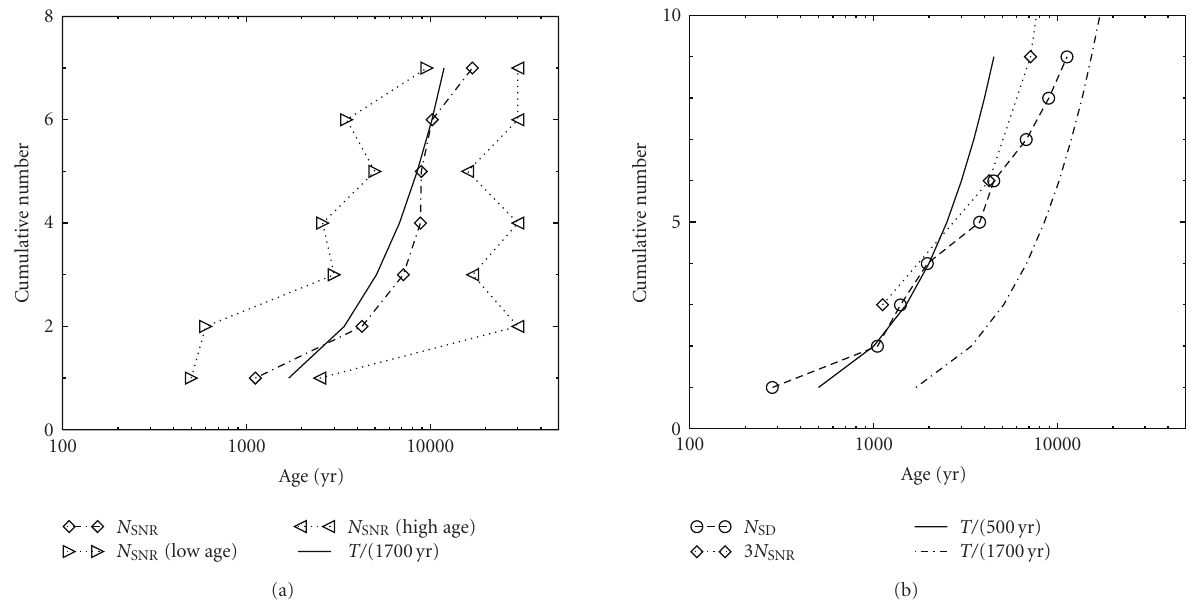
Figure 2: (a) shows the cumulative age distribution for SNRs associated with AXPs and SGRs (diamonds and dot-dashed line). The solid line is the expected distribution for constant birth rate of 1/(1700 years). The triangles indicate the upper and lower SNR age limits corresponding roughly to 3 σ limits. (b) shows the cumulative age distribution for AXPs/SGRs (circles and dashed line). The solid line is the expected distribution for constant birth rate of 1/(500 years). The diamonds and dotted line are the cumulative distribution for associated SNRs (from (a)) scaled up by a factor of 3. To better illustrate this scaling, the 1/(1700 years) line is replotted (dot-dashed line). Systematic errors in spin-down age would shift the x -axis and are in Section